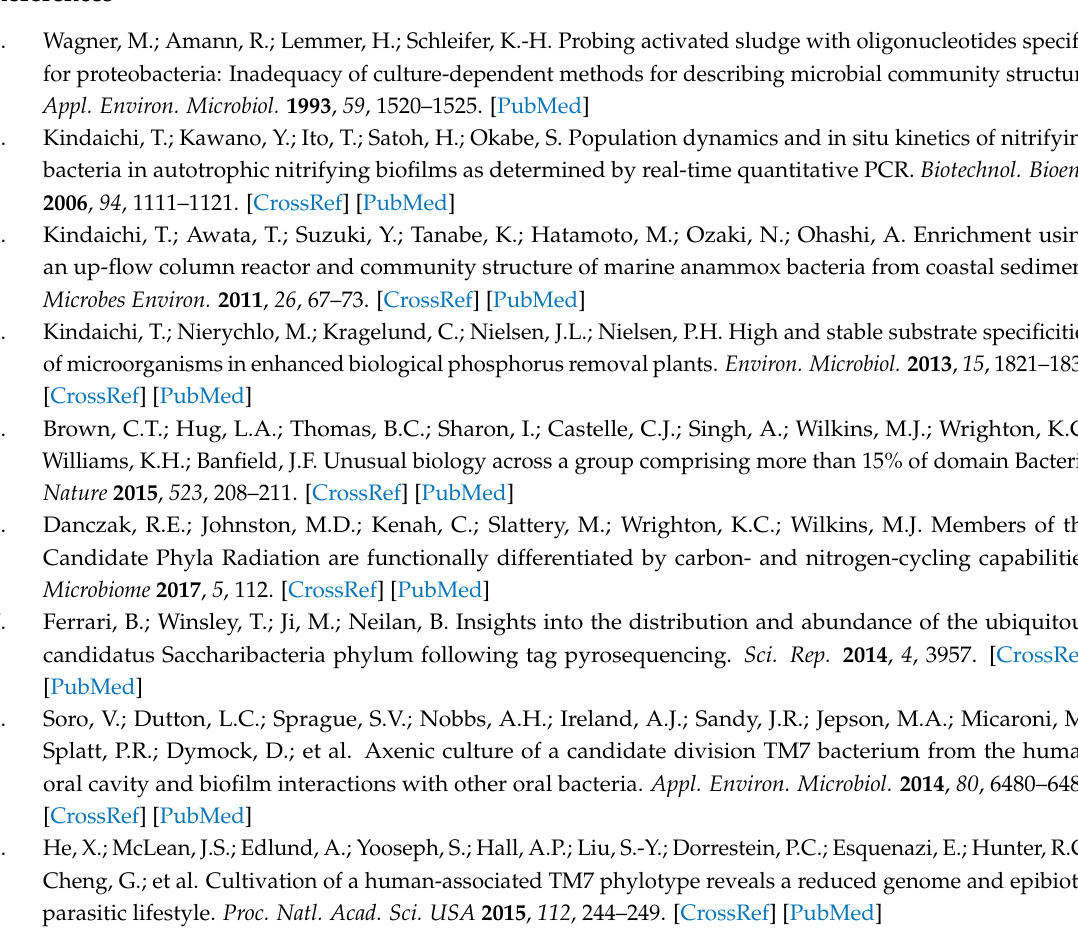
s1, Figure S1: Primer-target sequence mismatches of Saccharibacteria-specific primers evaluated in this study, Figure S2: Concentration of PCR product using the primer set with TM7314F and TM7-910R ( A ), TM7314F and TM7-1177R ( B ), TM7580F and TM7-910R ( C ), TM7580F and TM7-1177R ( D ), Sac1031F and Sac1218R ( E ), and 400F and 1110R ( F ), Figure S3: Phylogenetic tree of 1303 Saccharibacteria sequences and related operational taxonomic units (OTUs) obtained from activated sludge, Figure S4: Standard curves of Saccharibacteria qPCR for the measurement of copy number of plasmids using 10-fold serial dilutions of plasmid DNA carrying Saccharibacteria 16S rRNA genes and the four primer sets, Figure S5: Melting curves of the four standard curves using 10-fold serial dilutions of plasmid DNA carrying Saccharibacteria 16S rRNA genes and the four primer sets, Table S1: Phylogenetic relatives of the OTUs analyzed in this study. Please add the